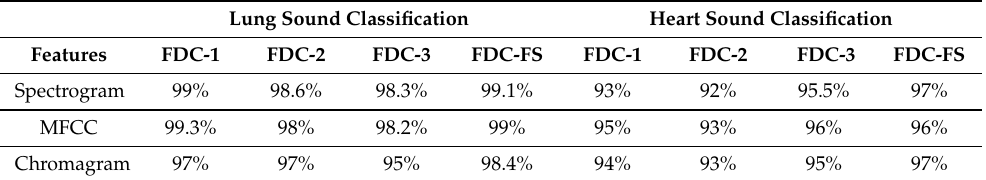
Table 9. Lung & Heart Condition Detection with Original Data (Testing Average Accuracy).